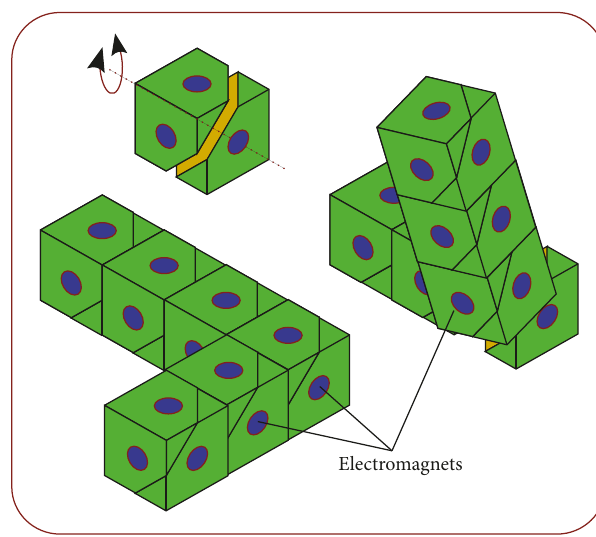
Figure 14: Model diagram and structures of Molecubes MSRR.